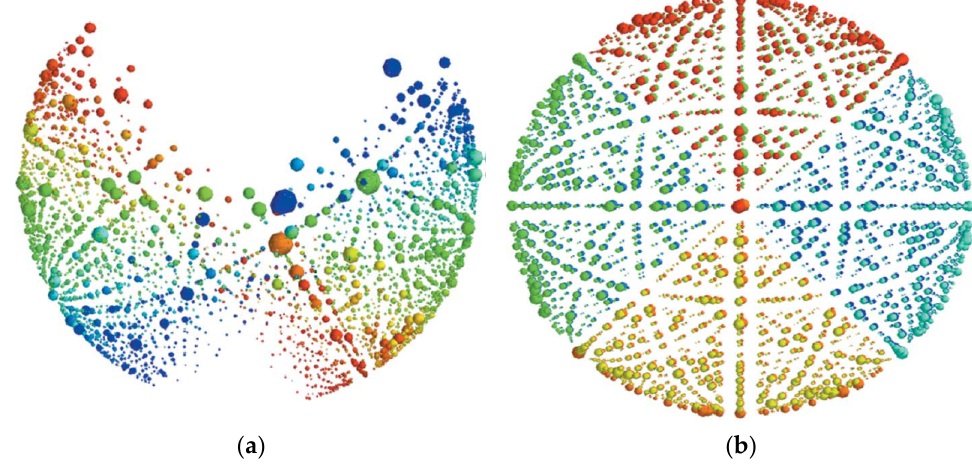
Figure 5. Visualization of normalized reciprocal-space vectors for ( a ) experimental Laue data set, and ( b ) reference monochromatic data. Figure reproduced with permission of the International Union of Crystallography from Kalinowski et al. [63].